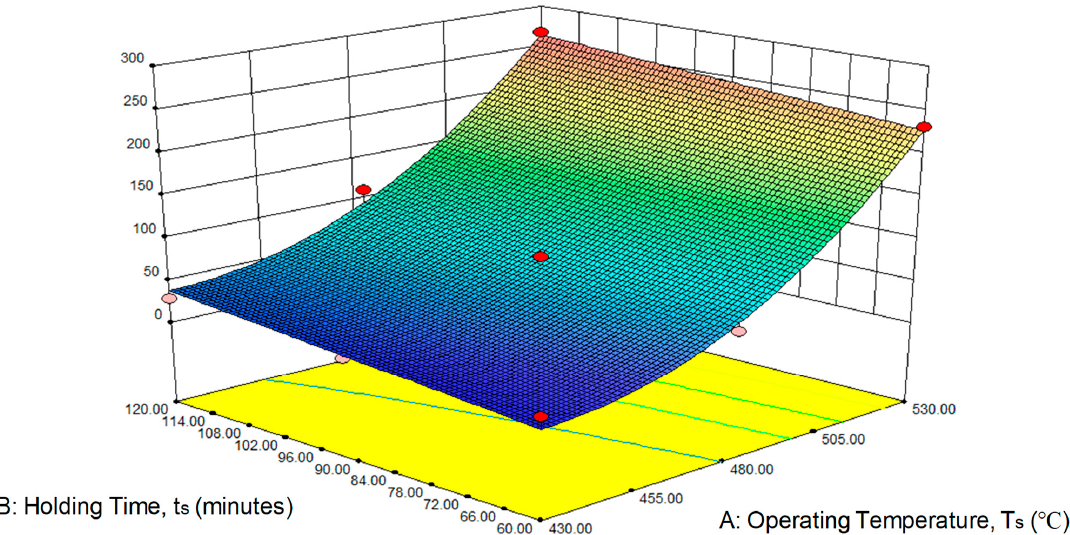
Figure 4. Effect of the ( A ) operating temperature and ( B ) holding time on ultimate tensile strength (UTS).